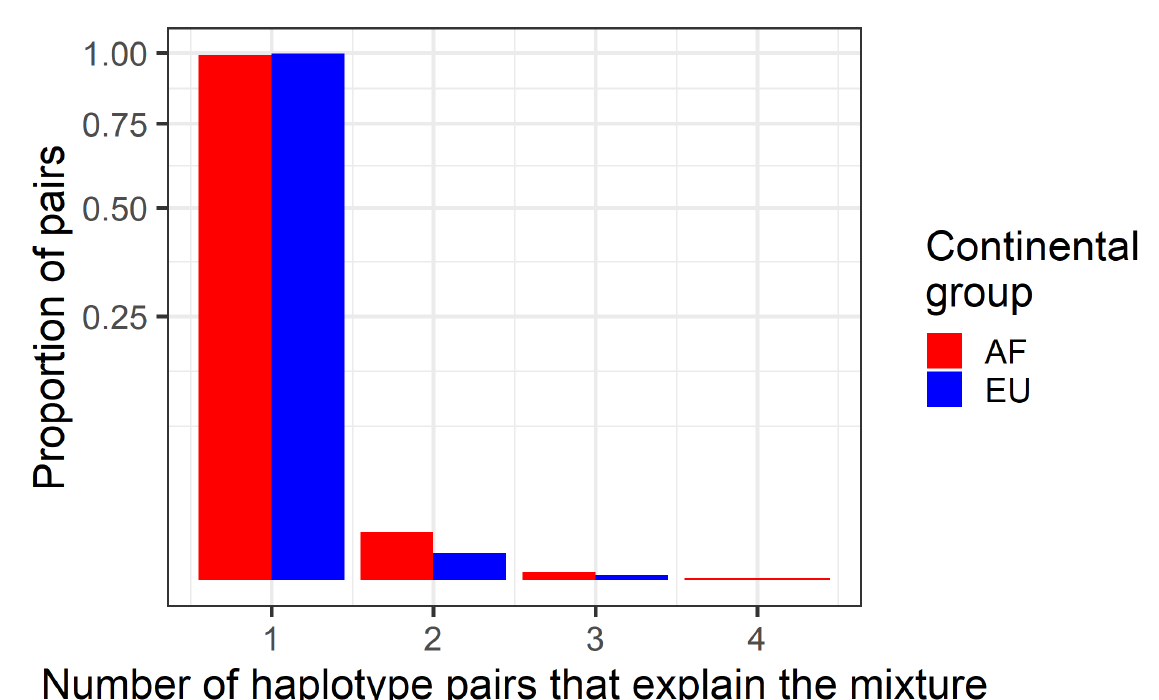
Figure 9. The proportion of haplotype pairs that explain two-person mixtures. Up to 100,000 in silico two-person mixtures were created using haplotypes from the Human Mitochondrial database (HmtDB). Mixtures were created within populations taking pairs of individuals from the African (AF) and European (EU) continental groups (colors). The number of distinct haplotype pairs that can then explain the mixture were tabulated ( x -axis) as well as the frequency of the occurrence ( y -axis, square root scale). Haplotype sampling occurred with replacement, thus the minimum number of haplotype pairs that can explain the mixture is one.